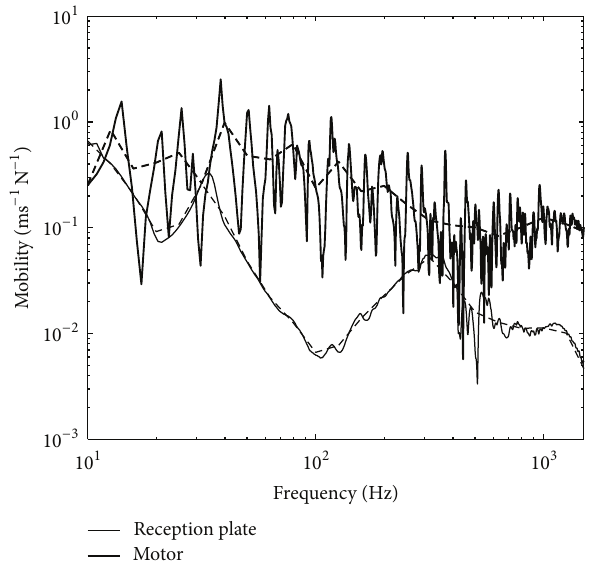
Figure 3: Comparison of measured average mobility from the high mobility reception plate and the fan motor: narrow band (solid line) and one-third octave band (dashed